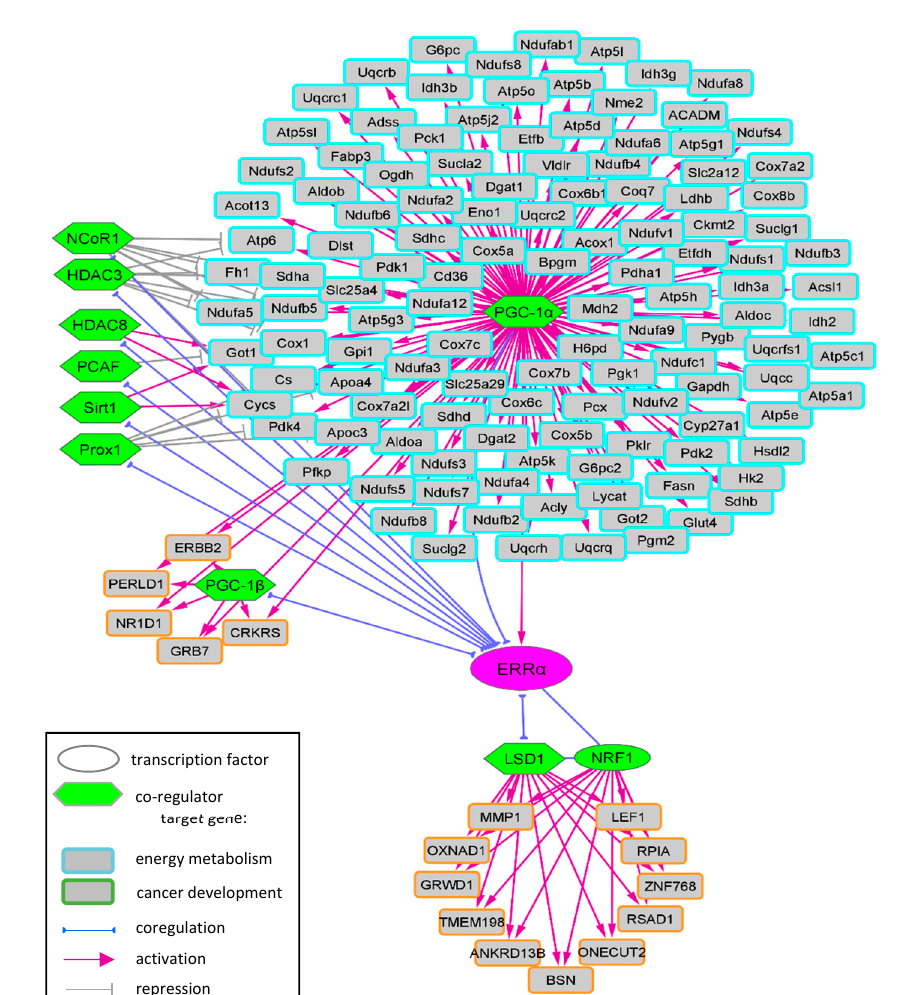
Figure 4. Transcriptional network of ERR α -PGC-1 and ERR α -LSD1 complexes. ERR α coactivators PGC-1 and LSD1, alone or in association with other co-regulators, control the expression of specific genes involved in energy metabolism or cancer development. Table 1. Summary of known ERR α coregulators and their associated target genes.